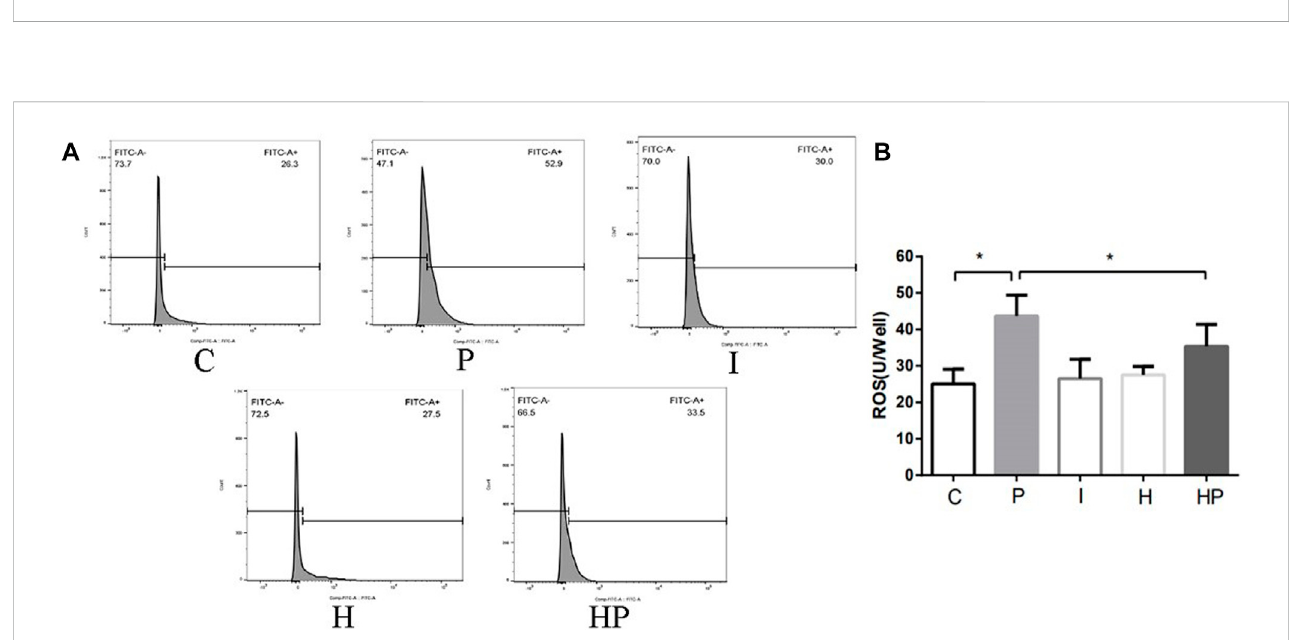
FIGURE 4 Changes in ROS in primary hippocampal neurons exposed to propofol with or without hypoxic preconditioning. (A,B) ROS content in each group (one- way ANOVA, * p < 0.05).